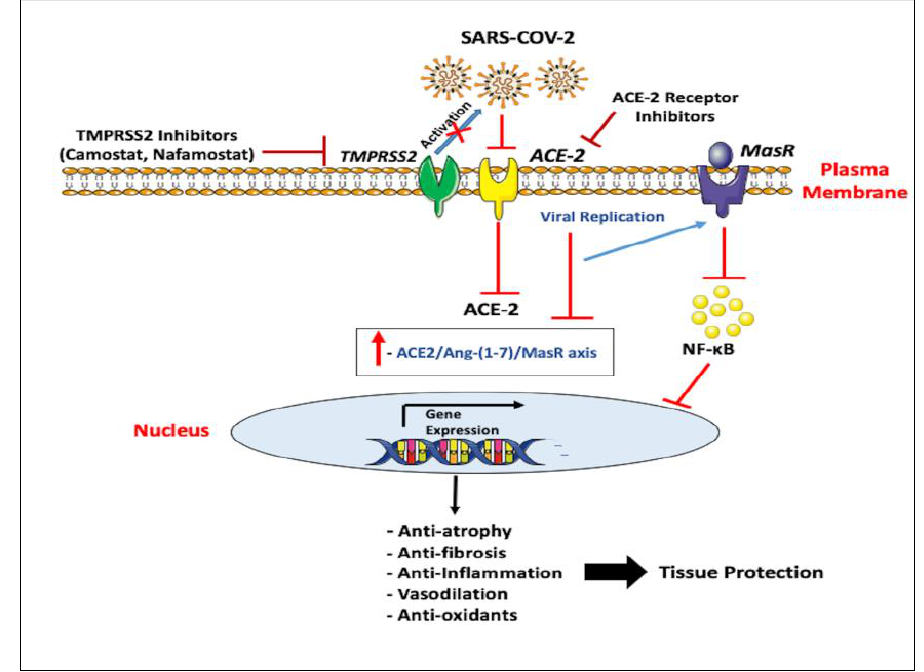
Figure 2. Potential therapeutic approaches to address ACE-2-mediated COVID-19 following SARS- CoV-2 infection. ACE-2 converts Ang-I to Ang (1–7) which acts through Mas receptor to protect from acute lung failure. On the other hand, the “spike” attachment protein for the current SARS-CoV-2 coronavirus uses the cellular attachment factor, (ACE-2) and requires TMPRSS2 cell protease for activation. Therapeutic approaches include TMPRSS2 inhibitors (Camostat and Nafamostat) that inhibit priming of the spike protein as well as blocking the surface ACE-2 receptor using anti-ACE-2 antibody or peptides which decrease viral entry into cells through competitively binding with SARS- CoV-2 thereby reducing viral spread and protecting the lungs from injury through its unique enzymatic